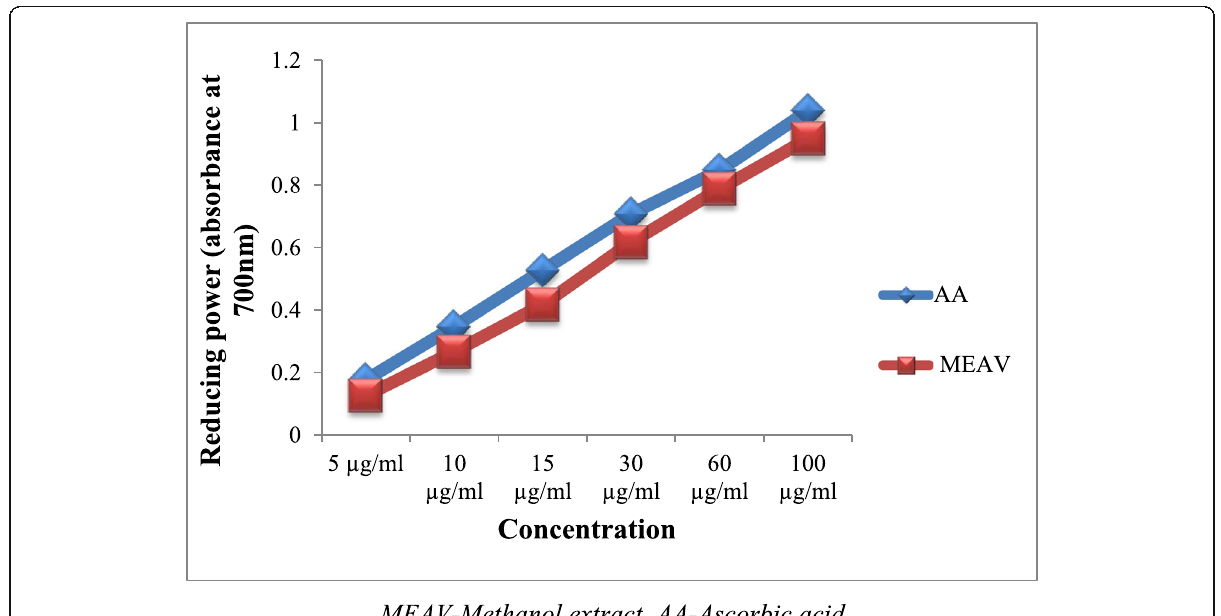
Fig. 2 Reducing power (absorbance vs different concentration) of A. vulgaris leaves extract and standard